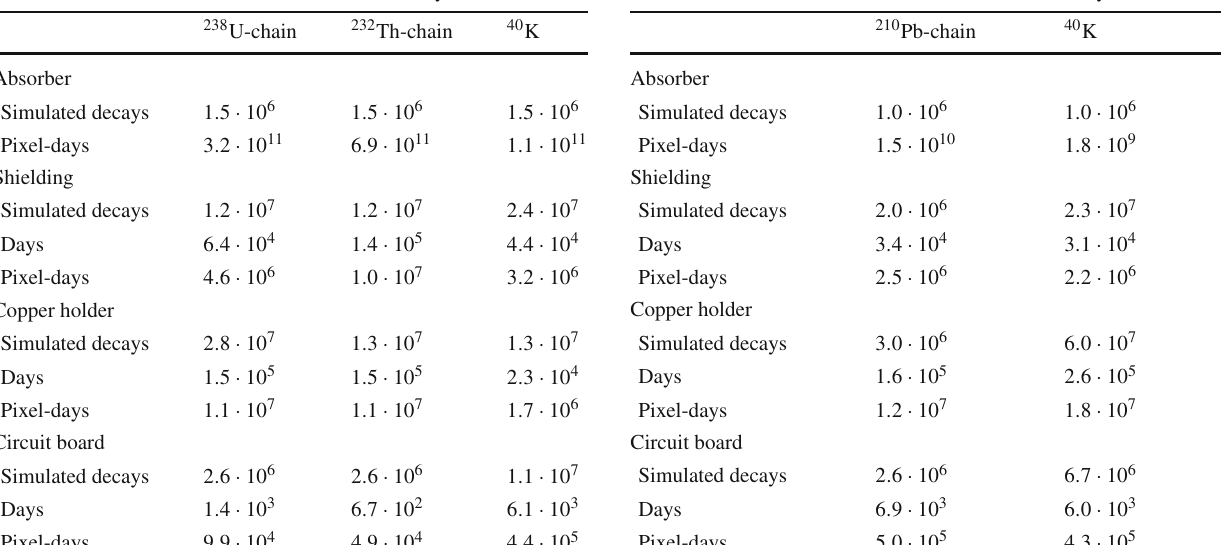
Table 4 Number of simulated bulk-distributed decay chains Table 5 Number of simulated surface-distributed decay